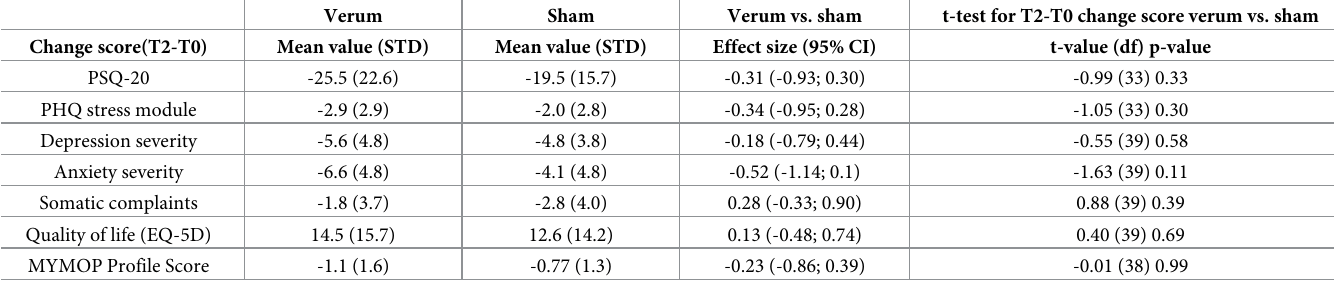
Table 4. Change scores and effect sizes for the PSQ-20 and additional stress-related variables at T2—Comparison between verum and sham group.